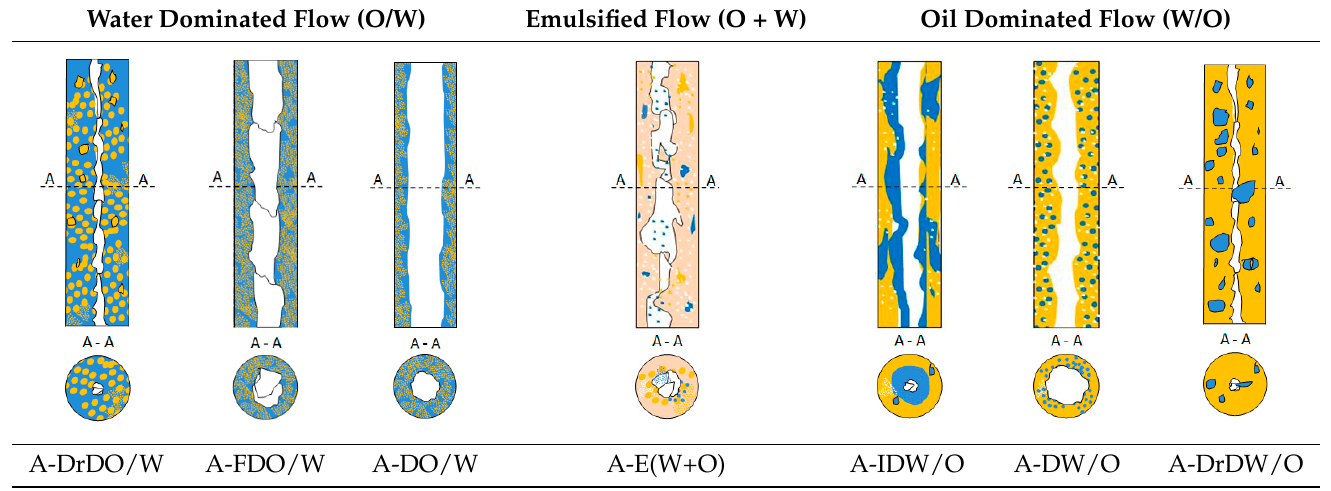
Table 5 presents detailed characteristics of the individual flow patterns observed during the experiment. The influence of the gas flow rate on the level of the dispersion of liquid components playing the most significant role in determining the values of the void and volume fractions of individual phases that formed the three-phase gas–liquid–liquid flow was determined for each type of the analyzed flow. Table 5. Description of flow patterns accompanying gas–liquid–liquid downflow.